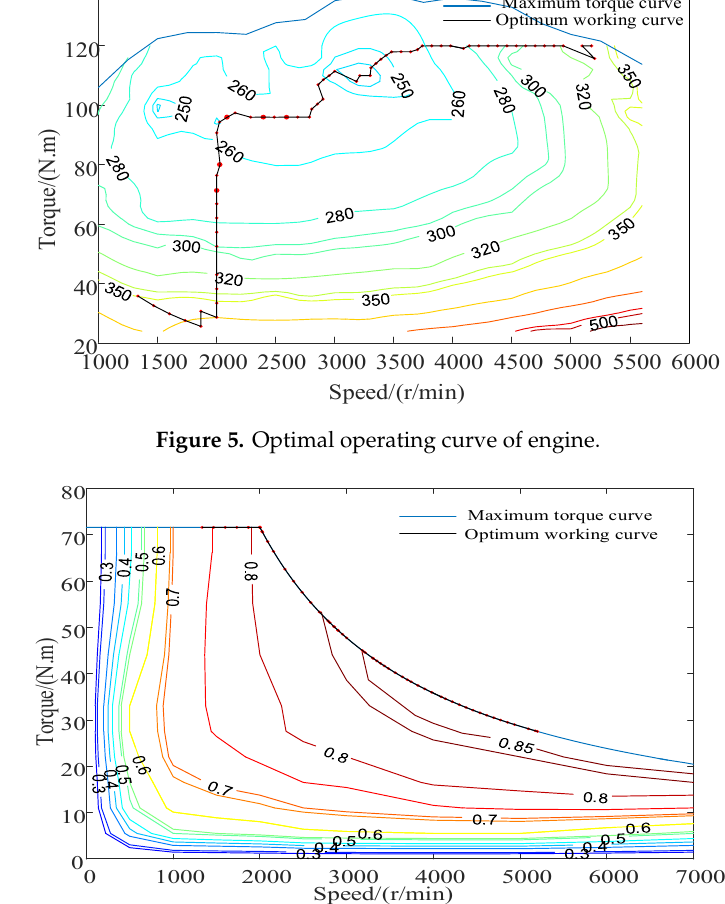
Figure 6. Optimal operating curve of motor.